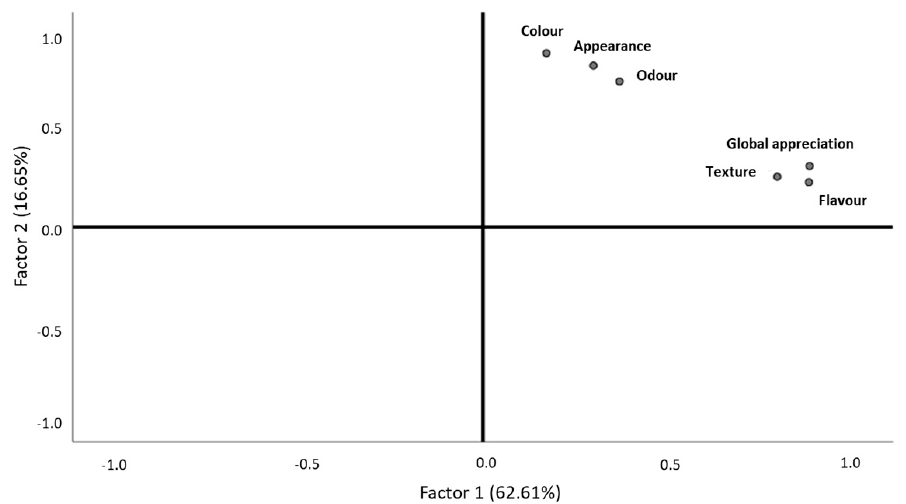
Figure 3. Behavior of black seabream ceviche descriptors, according to consumer classifications. Table 4. Rotated component matrix for each black seabream ceviche descriptor.